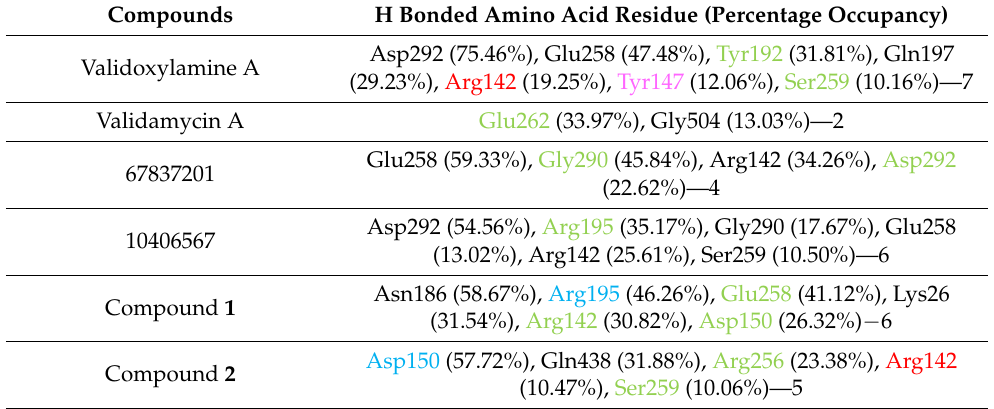
Table 8. Percentage occupancy of the